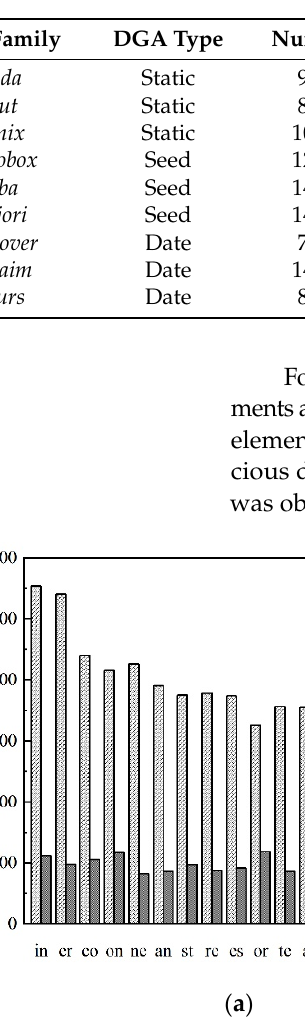
Figure 5. Distribution of legitimate and malicious domain phrase element frequencies. After using N-gram processing, the phrase elements were sorted from highest to lowest frequency. The fre- quency of the top 20 ranked phrase elements in legitimate domain names and those corresponding to malicious domain names were selected for comparison. ( a ) The processing result when N = 2. ( b ) The processing result when N = 3.